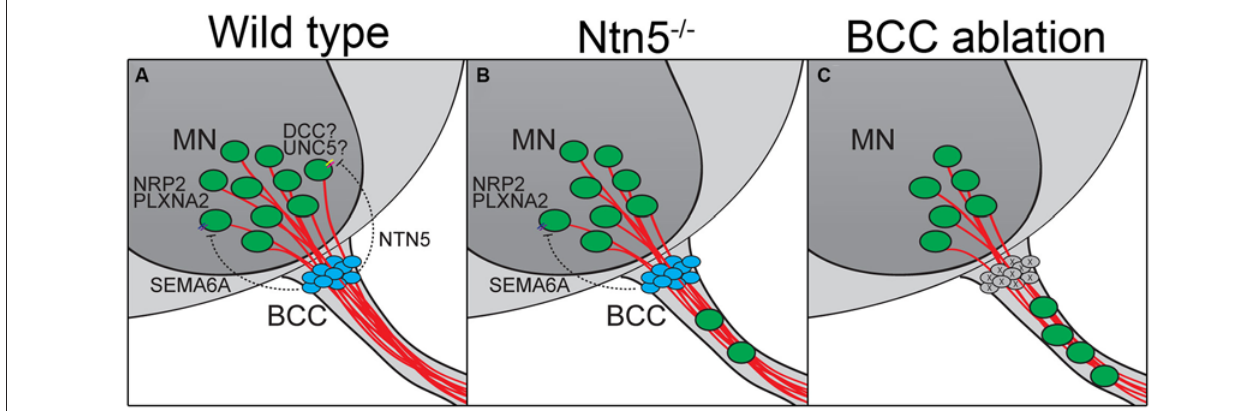
FIGURE 7 | BCC prevent motor neuron exit through multiple mechanisms . (A) BCC express SEMA6A, which signals through PLXNA2/NRP2 receptors on motor neurons (MN; Bron et al., 2007; Mauti et al., 2007). NTN5 from BCC prevent ectopic MN migration through putative interactions with DCC, probably in concert with an UNC5 receptor. In the absence of NTN5 (B) a subset of MNs exit the CNS. This is a separate subset from that depending on semaphorin signaling for proper positioning. When BCC are completely ablated (C) , more MNs enter the ventral root than in Ntn5 or Sema/Plxn/Nrp mutants alone (Vermeren et al., 2003).